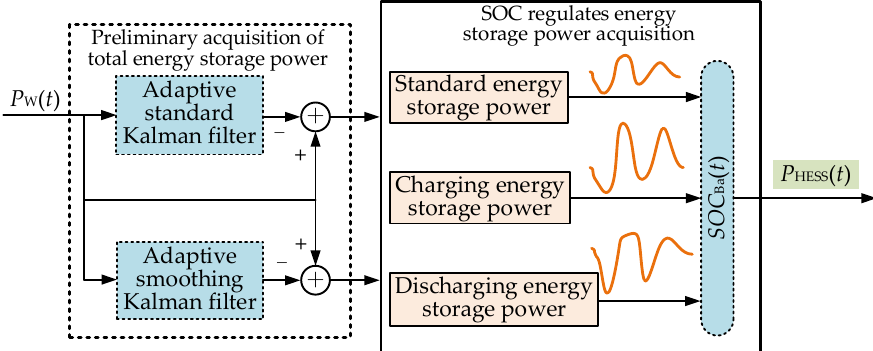
Figure 3. Energy storage power acquisition based on adaptive double Kalman filter.